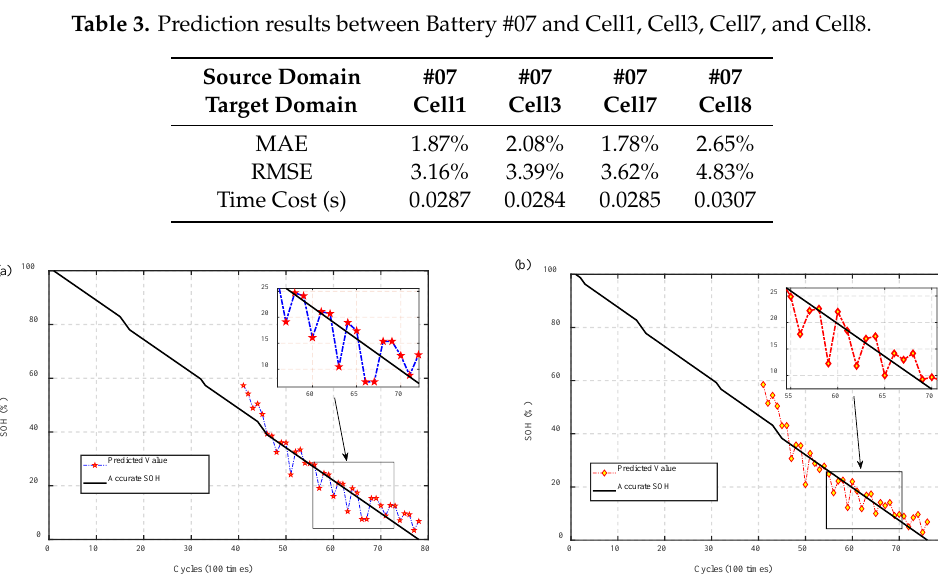
Figure 9. ( a ) Predicting the state of health (SOH) results of Cell1 using integral data of Battery #05. ( b ) Predicting the SOH results of Cell8 using integral data of Battery #05.